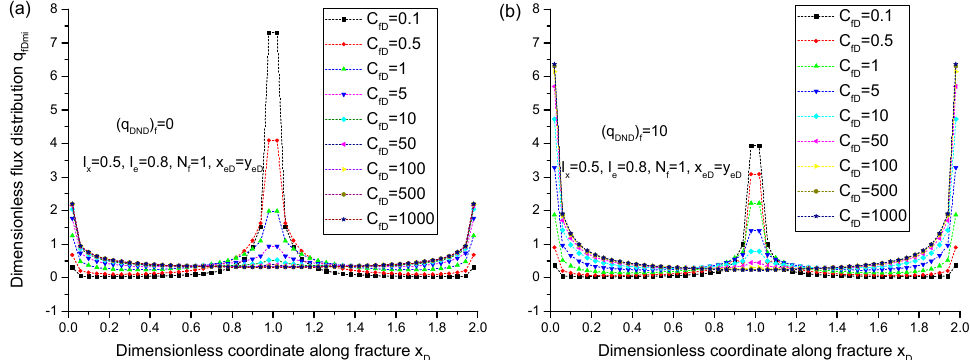
Figure 11. Influx-flow distribution along the fracture under the influence of conductivity ( a ) without and ( b ) with non-Darcy flow effect.